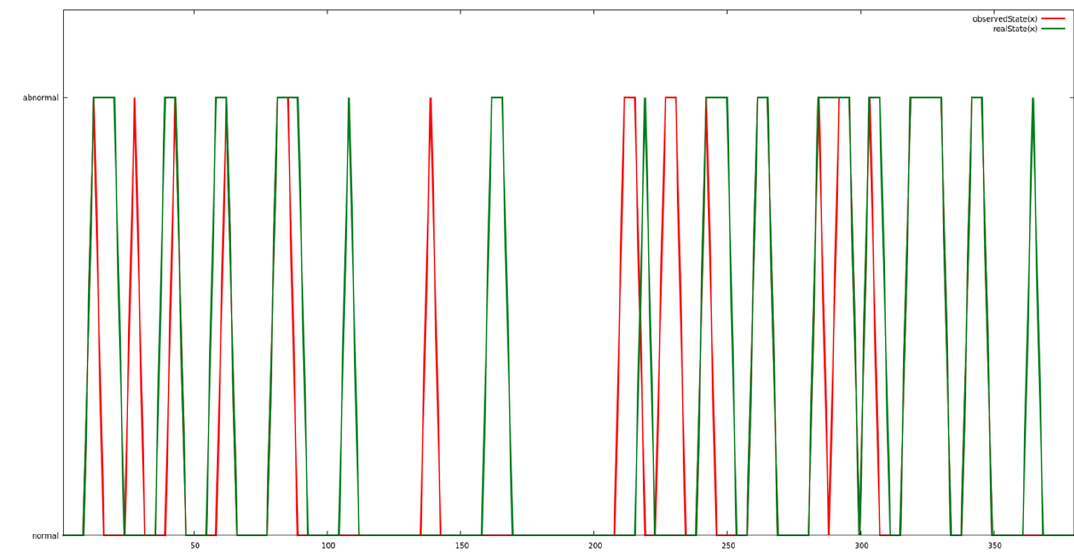
Figure 12. Results of abnormal cases detection by data prediction and analytic engine on QTRobot motor-state dataset.